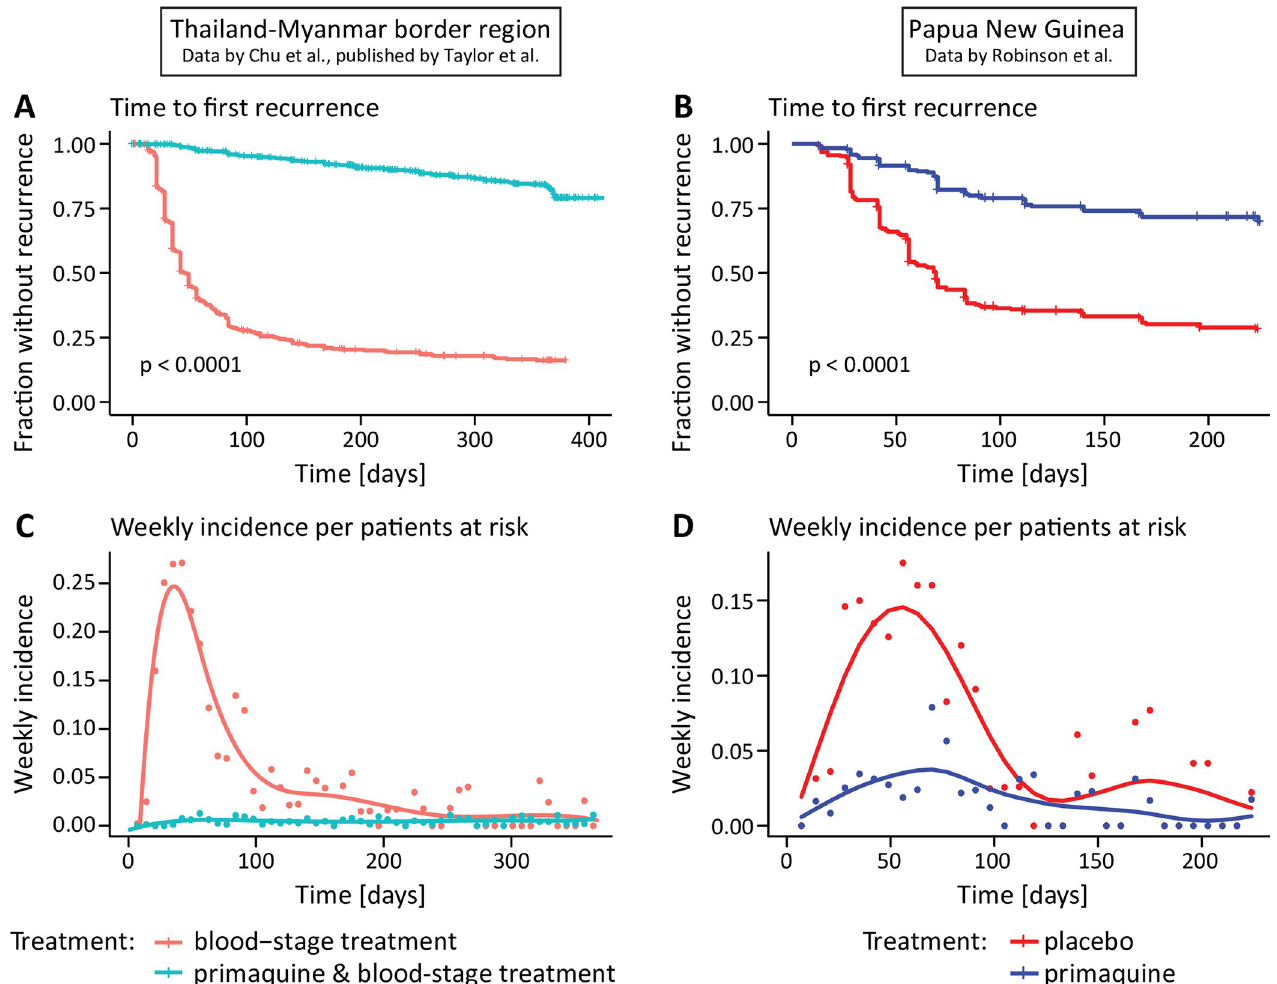
Fig 1. Time to first recurrence and weekly incidence per patients at risk in the Thailand-Myanmar and Papua New Guinea data. ( A , B ) Time from enrolment to the first recurrence for patients who received blood-stage treatment only (red) and patients who received primaquine and blood-stage treatment (blue). In the Papua New Guinea data, all patients (n = 504) received blood-stage treatment and either a placebo (red) or primaquine (blue). For the time to first recurrence in the Thailand-Myanmar data (n = 1298) by treatment and study see Fig H in S1 Figs ( C , D ) Weekly incidence per patients at risk for patients treated with primaquine and blood-stage treatment (blue dots) and blood-stage treatment only (red dots). The weekly incidence per patients at risk is the number of patients that had a recurrence within the current week divided by the number of patients who were at risk (i.e., the patients who have not yet had a recurrence) at the beginning of the week. The curves are fitted to the weekly incidence per patients at risk (using splines).